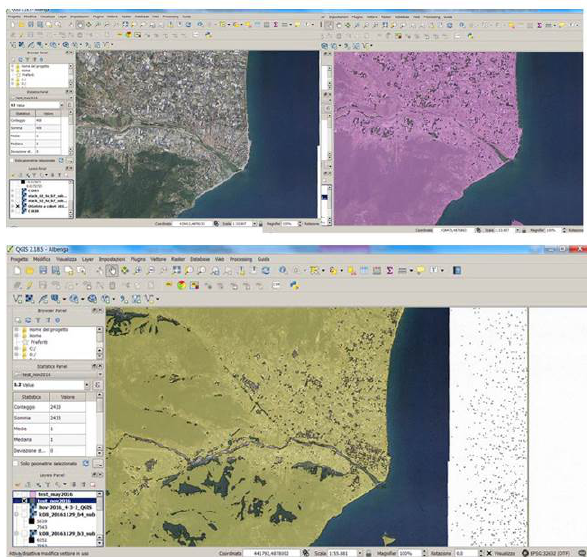
Figure 7 Orthophoto of Liguria region provided as a Web Map Service (WMS) by local authorities (above left); Vector values of NDVI results in May 2016 superimposed to orthophoto (above right); Vector values of NDVI results in Nov 2016 superimposed to orthophoto (below).